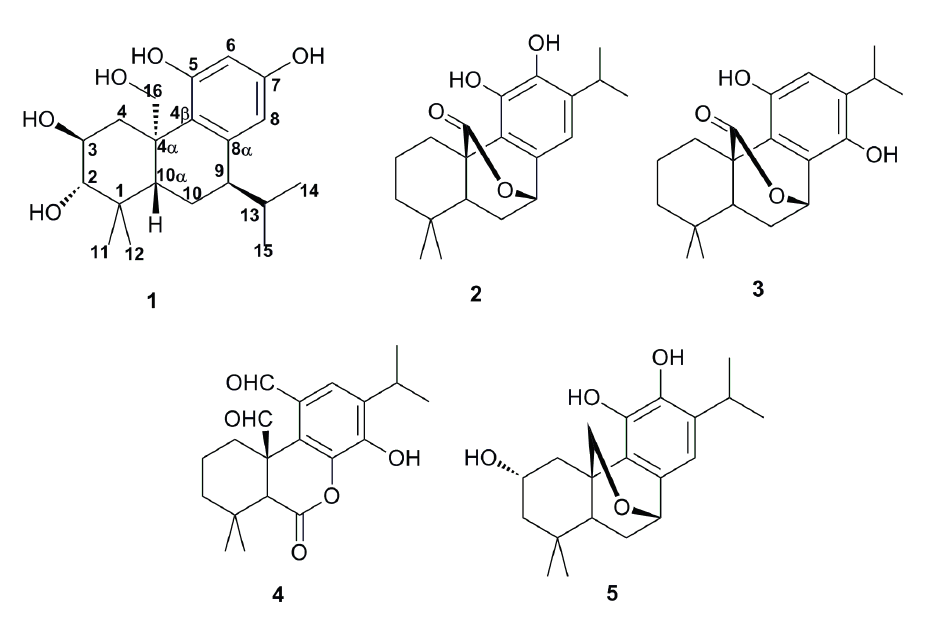
Figure 1. Structures of compounds 1 – 5